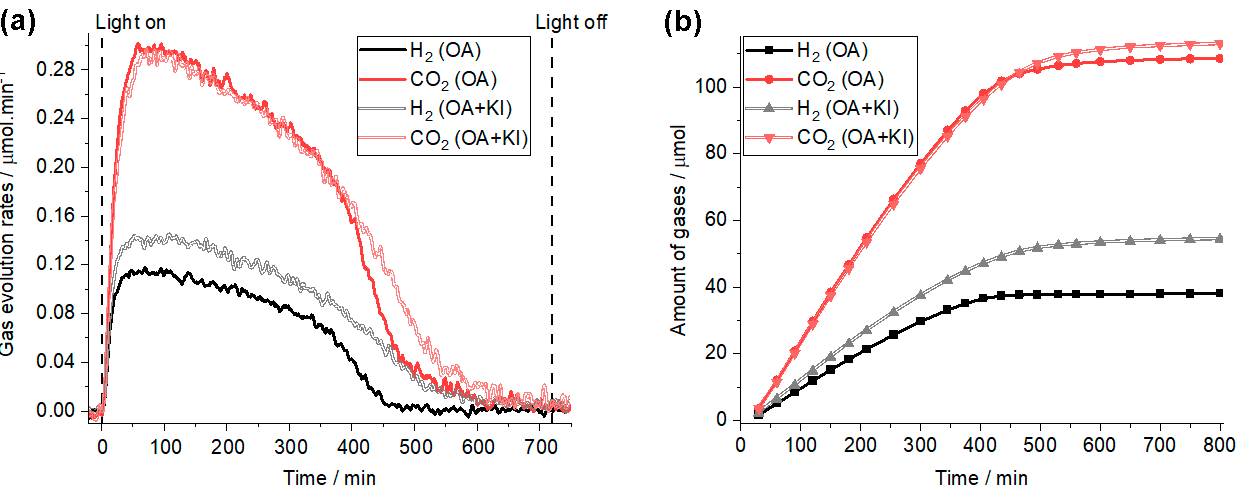
Figure 4. QMS signals ( a ) for the evolution of H 2 and CO 2 from the reforming of oxalic acid with and without the presence of 20 mmol L − 1 KI. The evolved amounts ( b ) of H 2 and CO 2 . A 50 mL aqueous suspension containing 1.11 mmol L − 1 oxalic acid at pH ~3 on Pt/TiO 2 . A longpass filter with a cut-on wavelength of 310 nm was used.